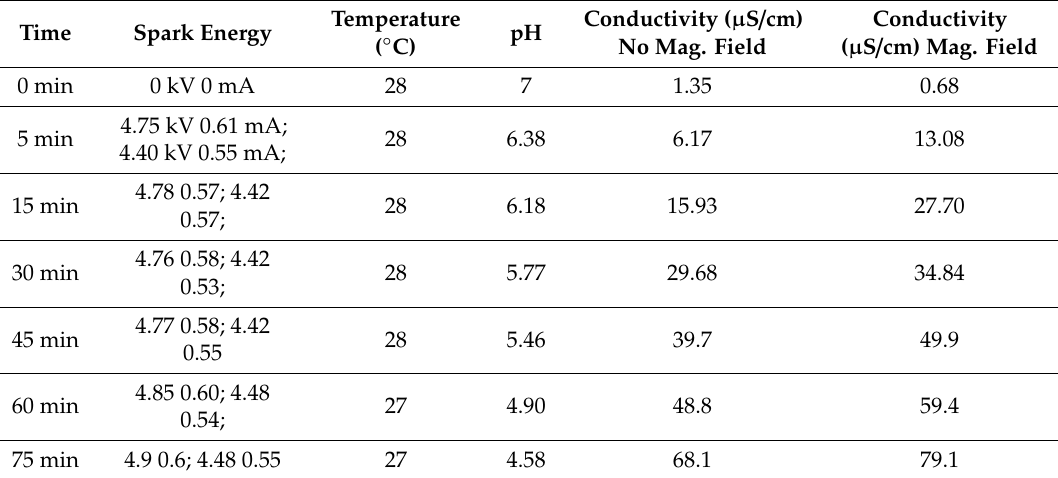
Table 3. DI water parameters of sparking aluminium